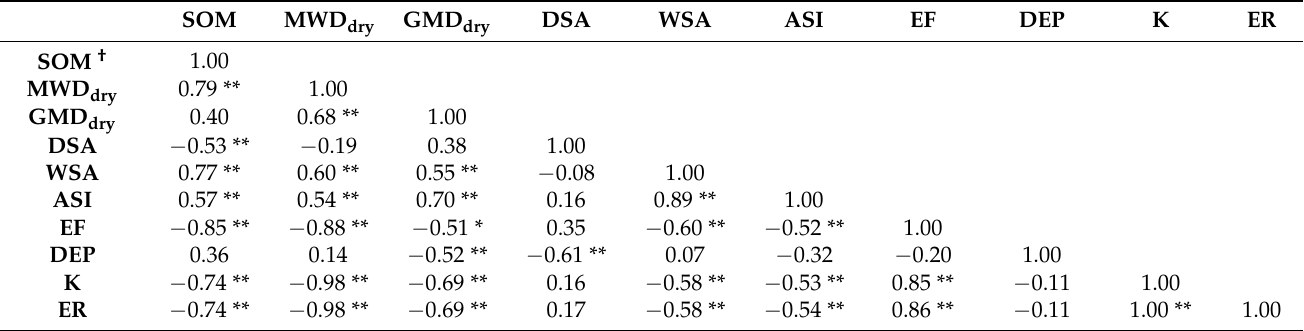
Table 3. Correlation coefficient (r) among studied soil organic matter, aggregate stability, and erosion indices (n = 24). SOM MWD dry GMD dry DSA WSA ASI EF DEP K ER